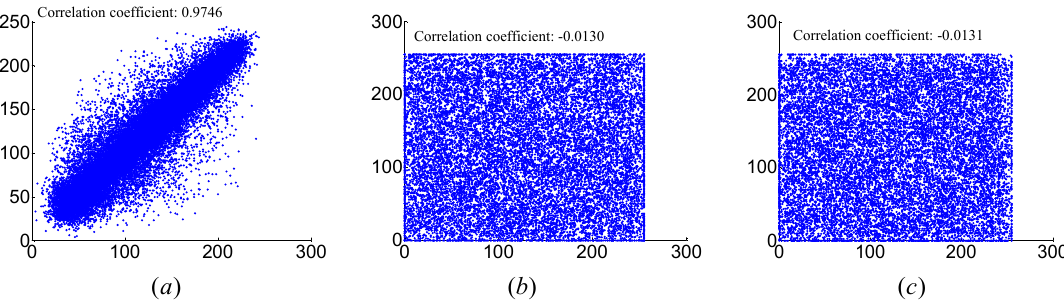
Figure 4. Histograms of Lena and the generated shares. ( a ) The histogram of “Lena” ( b ) the histogram of shares in G 1 ( c ) the histogram of shares in G 2 .